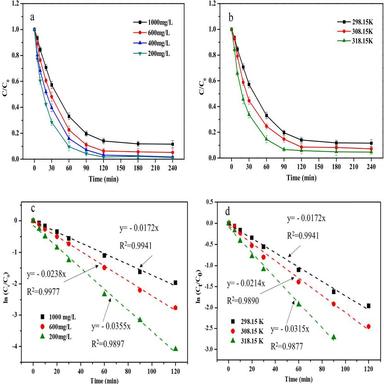
Effect of initial concentration (a); temperature (b) on AO7 elimination efficiency; curves of fitted pseudo-first-order degradation kinetics on AO7 at various initial concentrations (c) and temperatures (d).